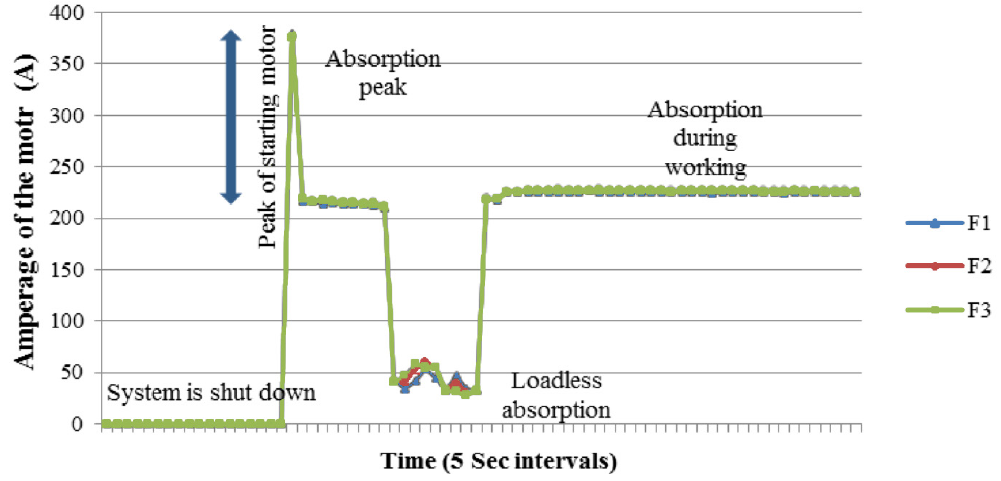
Figure 3. Typical electrical energy absorption of the motor.